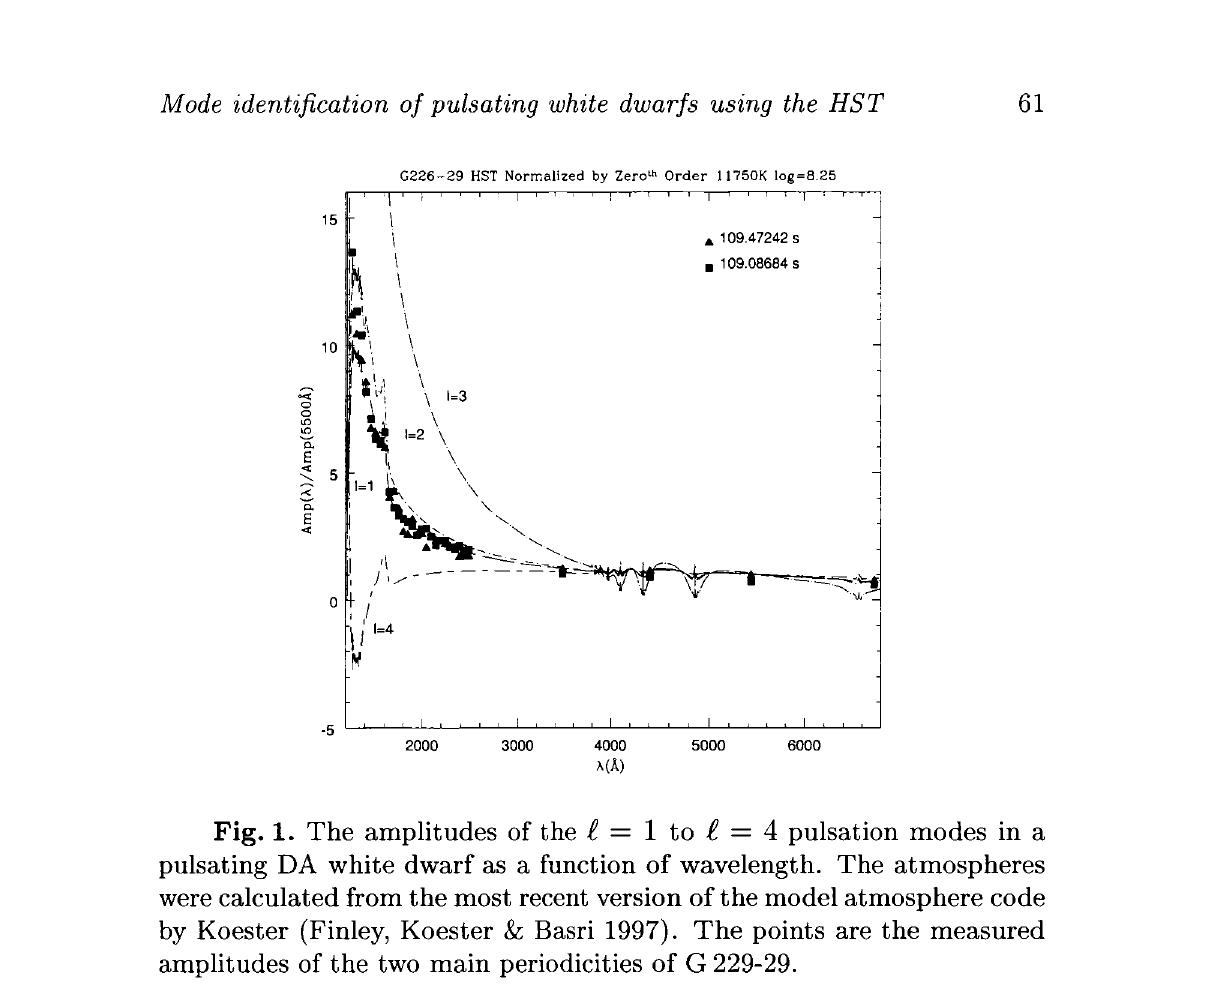
Fig. 1. The amplitudes of the i = 1 to t = 4 pulsation modes in a pulsating DA white dwarf as a function of wavelength. The atmospheres were calculated from the most recent version of the model atmosphere code by Koester (Finley, Koester & Basri 1997). The points are the measured amplitudes of the two main periodicities of G